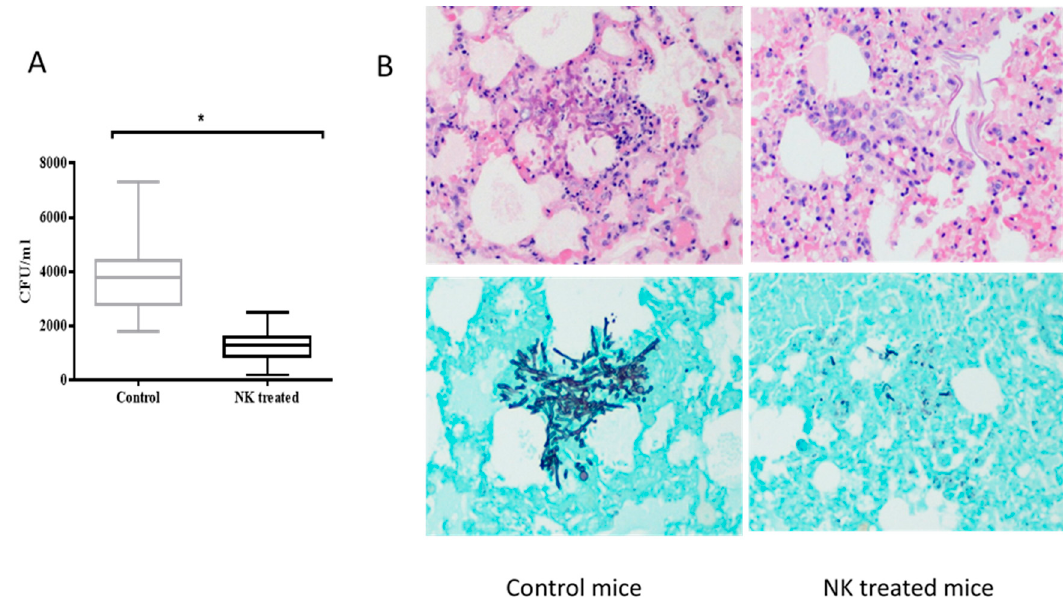
Figure 6. Fungal burden in neutropenic mice treated with expanded NK cells. Mice were infected with Aspergillus followed by treatment with either expanded NK cells or PBS for 2 consecutive days. The lungs were harvested following the infection and treatment. ( A ) The fungal burden in mice treated with expanded NK cells compared to the PBS treated controls. 20 mice each were pooled from 3 experiments + SEM (* p < 0.05). ( B ) Lungs from 5 mice each in NK or PBS treated groups were stained with H&E (top panel) and GMS (bottom panel) and × 200 magnification was used to identify fungal structures and visualize host response.